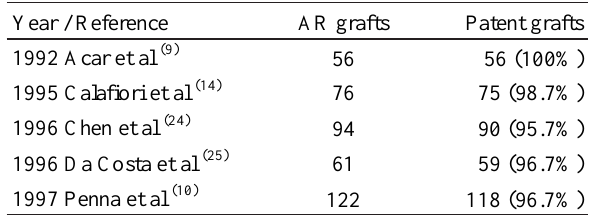
Table 2. Review of the literature about the early patency rate of the radial artery